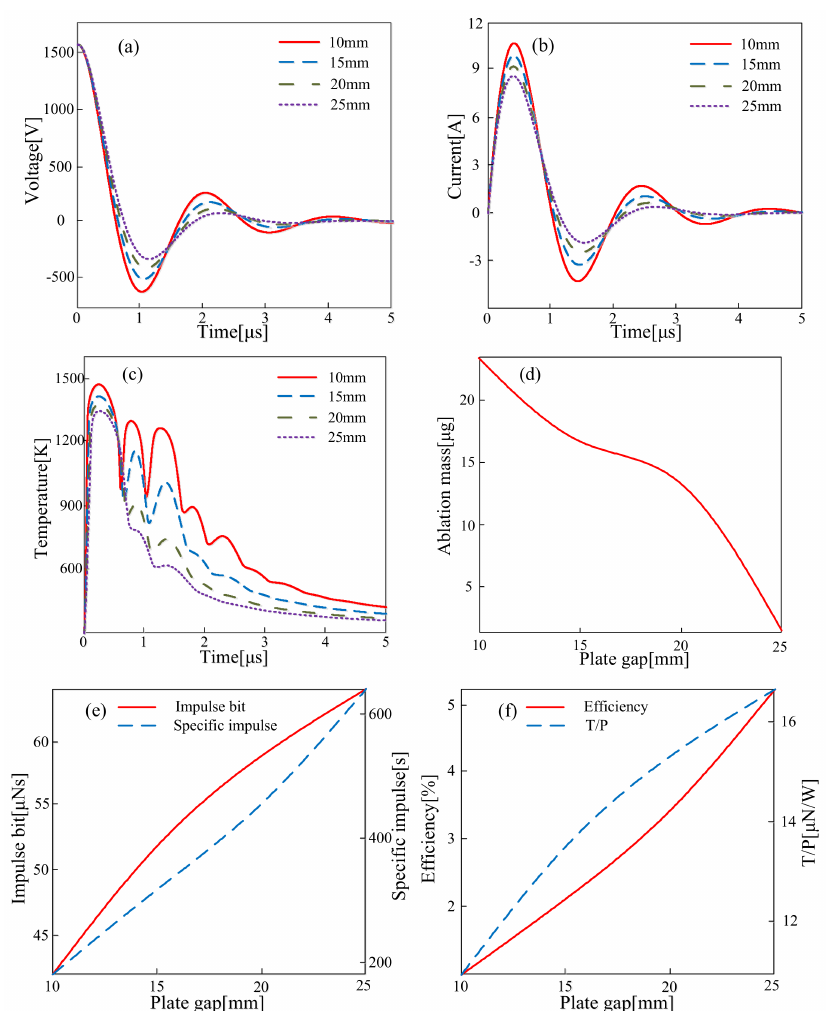
Figure 11. Simulation results at different plate gaps: ( a ) Discharge voltage waveform; ( b ) discharge current waveform; ( c ) variation of ablation surface temperature with time; ( d ) variation of ablation mass with plate gap; ( e ) variation of impulse bit and specific impulse with plate gap; ( f ) variation of efficiency and ratio of thrust to power with plate